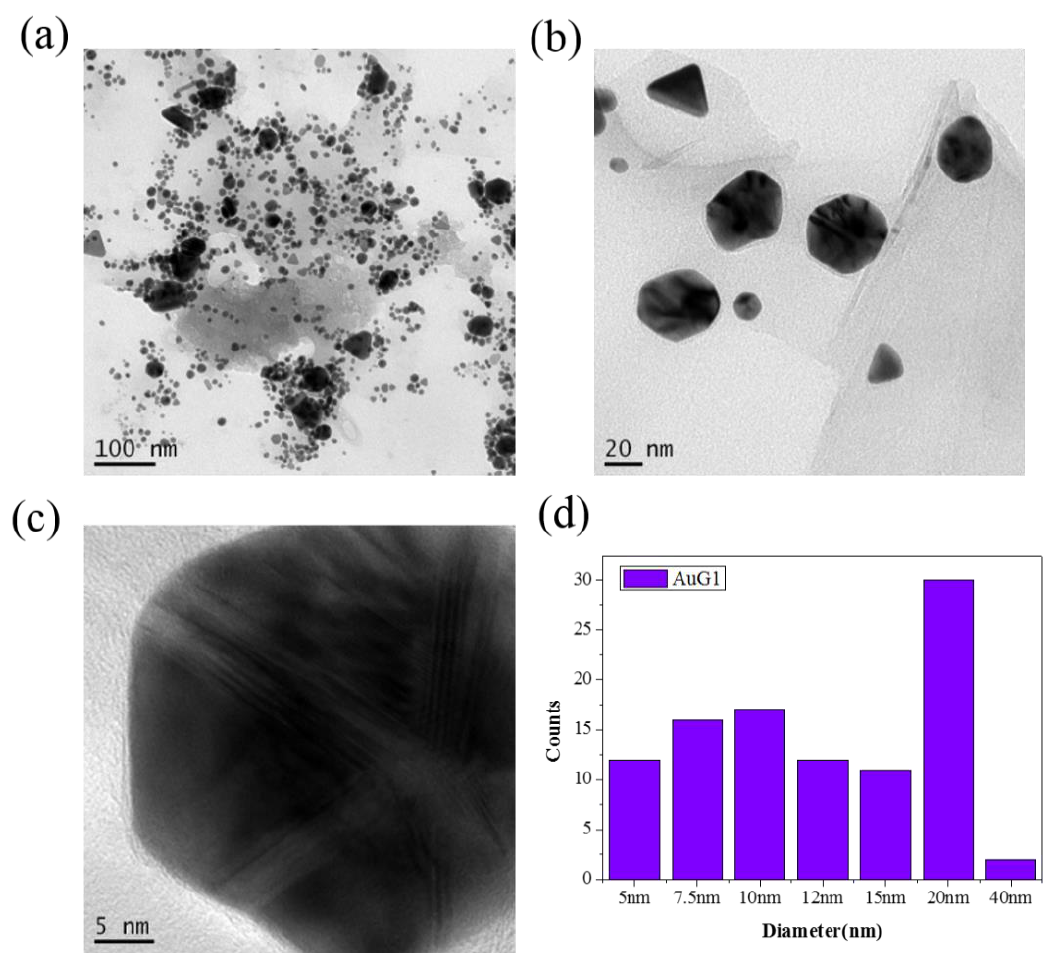
Figure 4. TEM image of different magnification ( a–c ) and ( d ) corresponding size distribution of Gr/Au NCPs (Sample AuG1).